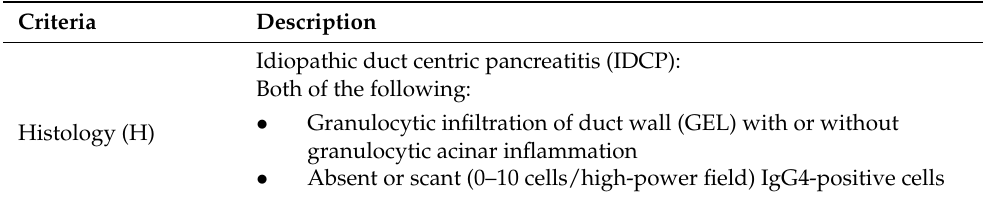
Table 5. Simplified international diagnostic criteria for type 2 autoimmune pancreatitis (created in accordance with Shimosegawa et al.